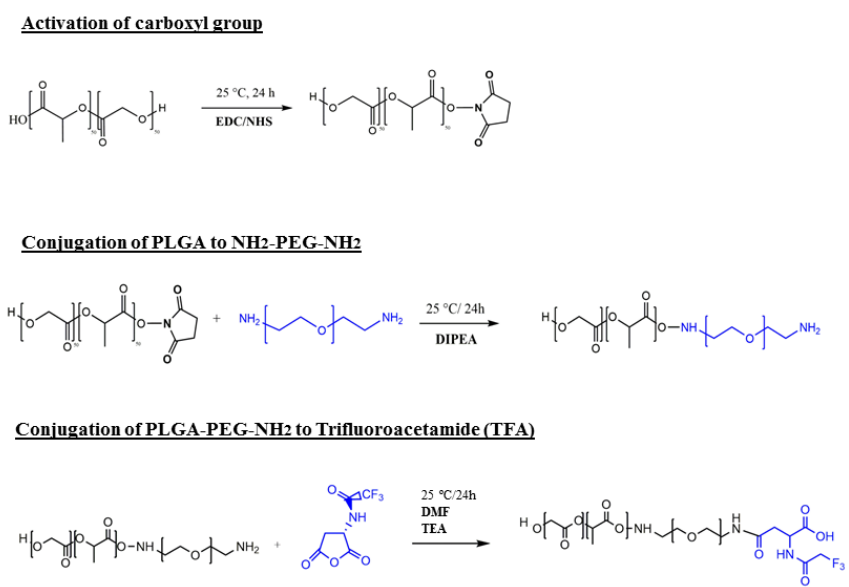
Figure 1. Schematic representation and synthetic procedure of PLGA-PEG-TFA (poly (lactic-co- glycolic acid)-polyethylene glycol-trifluoroacetamide) formulation.